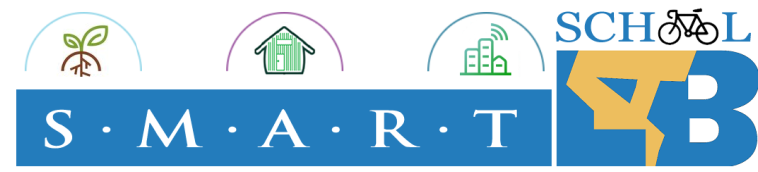
Figure 3. Smart School Lab logo.